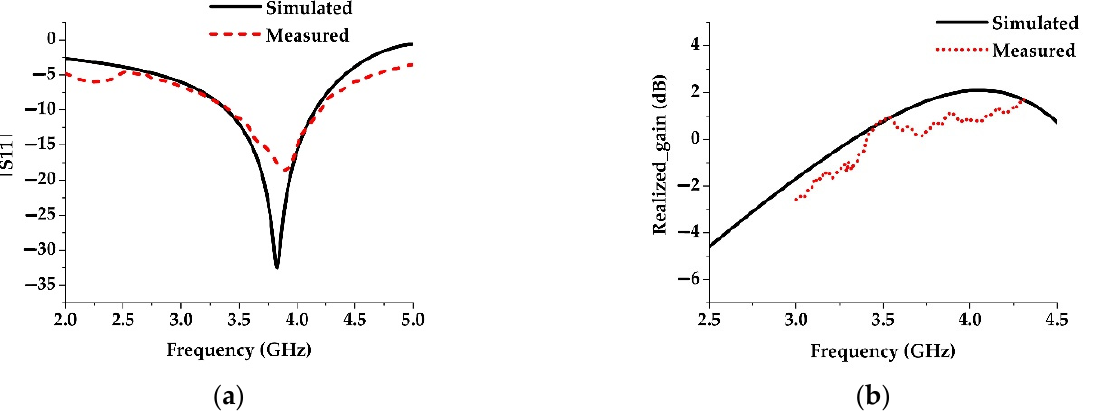
Figure 14. Simulated and measured ( a ) reflection coefficient and ( b ) realized gain of the proposed antenna.